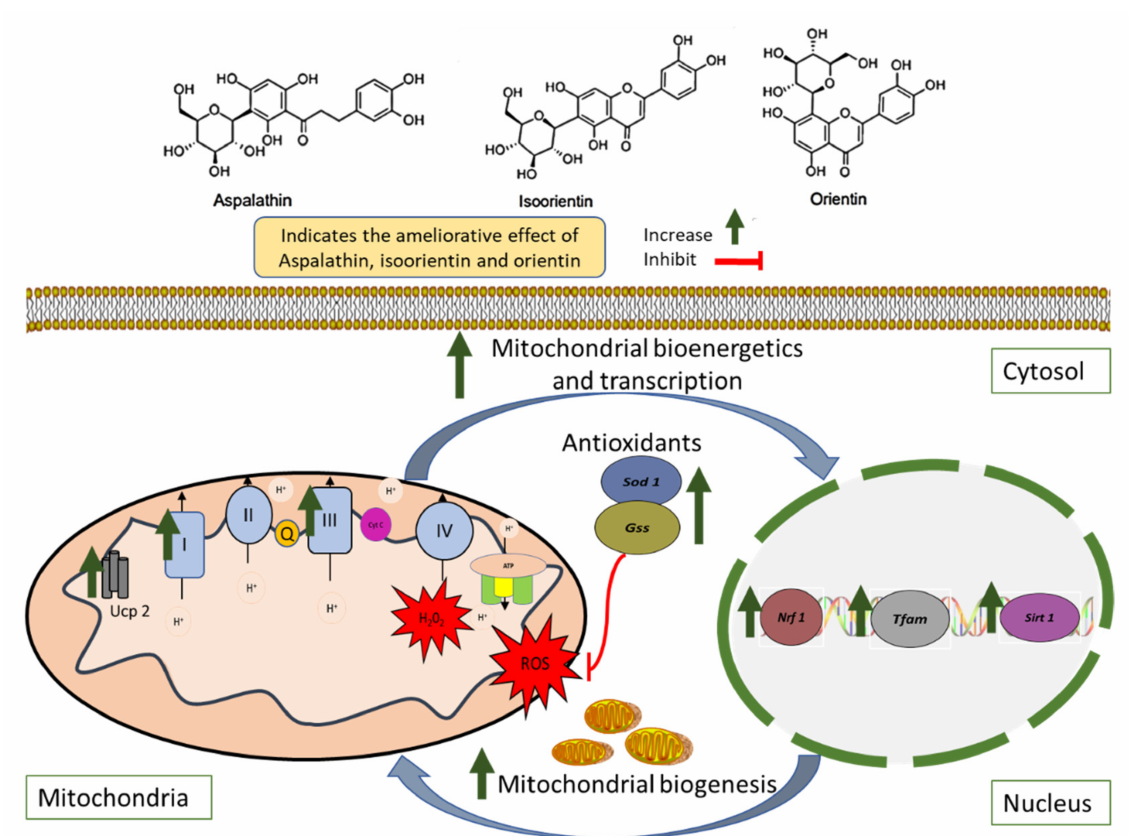
Figure 6. An overview of some therapeutic mechanisms linked with the ameliorative effect of rooibos flavonoids, aspalathin, isoorientin, and orientin against the complications involved in the development of mitochondrial dysfunction within the skeletal muscles. In brief, rooibos flavonoids aspalathin, isoorientin, and orientin showed the potential to improve mitochondrial bioenergetics through the upregulation of genes involved in electron transport complexes ( Complex 1 and Complex 3 ) and uncoupling protein 2 ( Ucp 2 ). In partial part, due to their antioxidant properties, these flavonoids also reduced excessive reactive oxygen species (ROS) while increasing the regulation of antioxidant genes such as